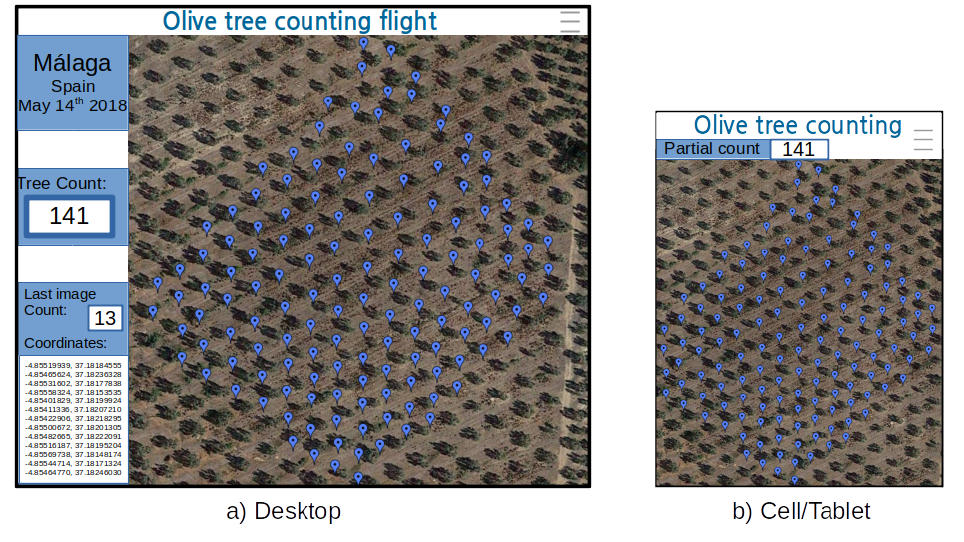
Figure 12. User application interface on different